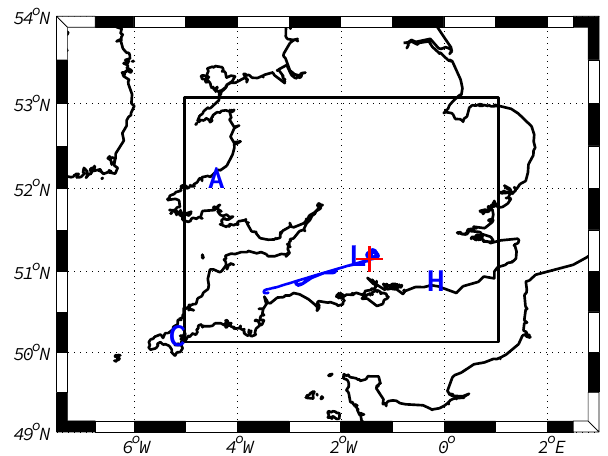
Fig. 1. The 253 degree radial and flight track (blue) of the FAAM BAe146 aircraft on the 22 January 2009 (see Table 1 for details of runs/manoeuvres). Also shown are: the location of CFARR (red cross); the location of radiosonde stations at Cambourne, Larkhill, Herstmonceux and Aberporth (C, L, H and A respectively). The inner box highlights the 3rd or inner domain used in the WRF model sensitivity studies (see Sect.